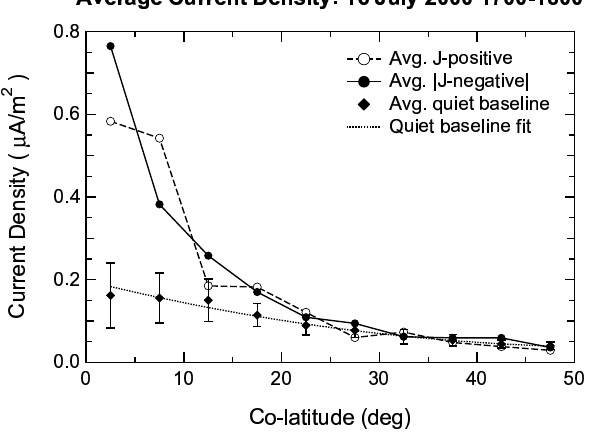
Fig. 3. Local time averaged distribution of the upward (open cir- cles) and downward (closed circles) Birkeland currents on 16 July 2000, 16:00–17:00 UT. The quiet-time noise level is represented by